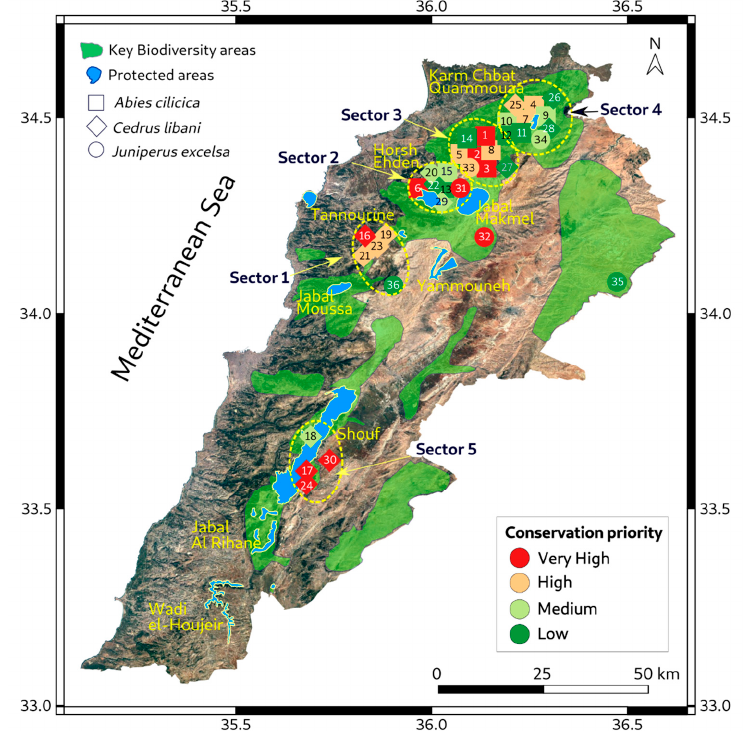
Figure 4. Conservation priority from very high to low (red to green) for 15 populations of Abies cilicica (squares), 15 populations of Cedrus libani (diamonds), and 6 populations of Juniperus excelsa (circles), based on the conservation index developed in Table 1. National protected areas (blue areas) and Key Biodiversity Areas (green areas) were digitized from [34] and https://www.keybiodiversityareas.org/ (accessed on 1 April 2022), respectively.